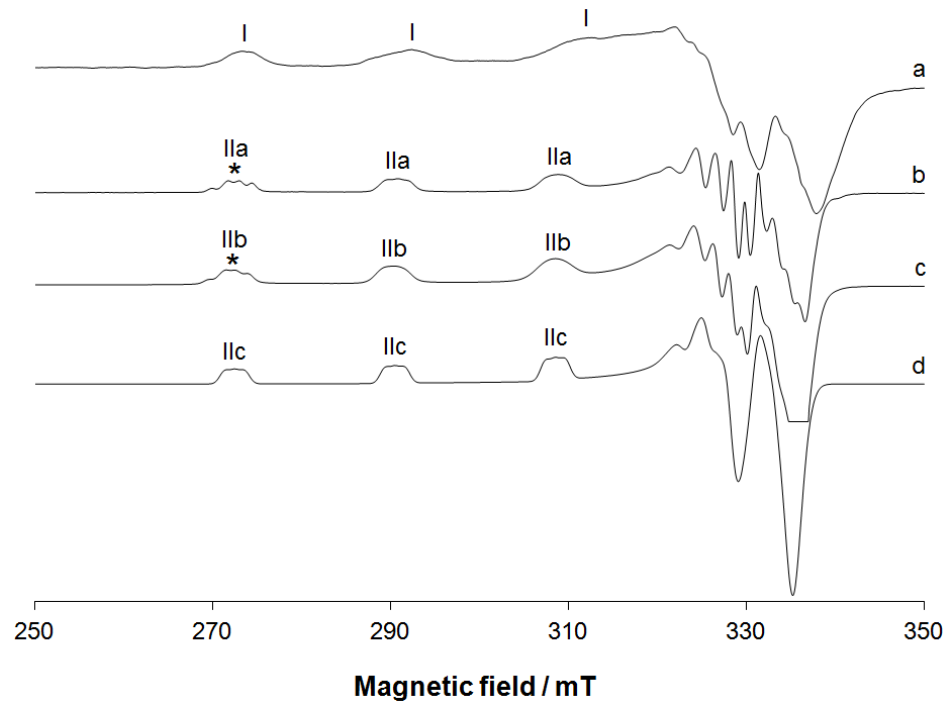
Figure 2. X-band anisotropic EPR spectra recorded at 120 K on the polycrystalline complex [Cu(HHSB)(AcO)]: ( a ) solid powder; ( b ) dissolved in DMF; ( c ) dissolved in DMSO and ( d ) dissolved in a mixture H 2 O/DMSO 60/40 v / v . With I , IIa , IIb and IIc the resonances of [Cu(HHSB)(AcO)], [Cu(HHSB)(DMF)] + , [Cu(HHSB)(DMSO)] + and [Cu(HHSB)(H 2 O)] + are indicated. With an asterisk the superhyperfine coupling with 14 N nucleus is also denoted.